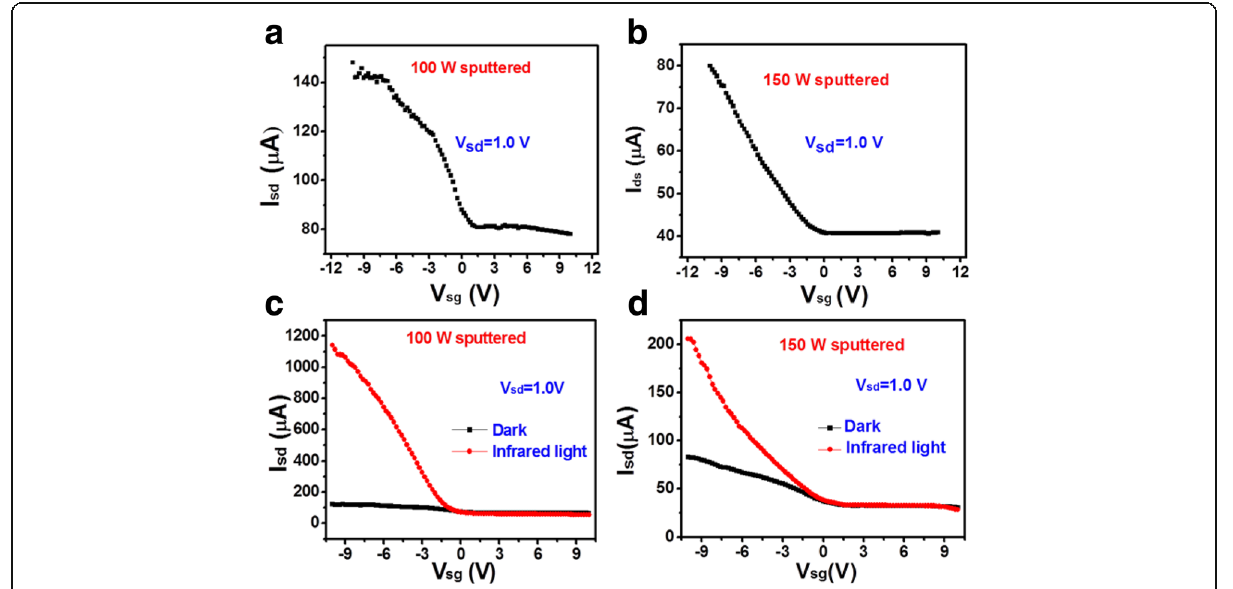
Fig. 4 IR characterization. ( a ) and ( b ) I sd -V sg curves of the GFET with MnZn ferrite thin film sputtered at 100 and 150 W, respectively. ( c ) and ( d ) compare the I sd -V sg curves under IR illumination and no illumination. The voltage applied between source and drain is 1.0 V for all